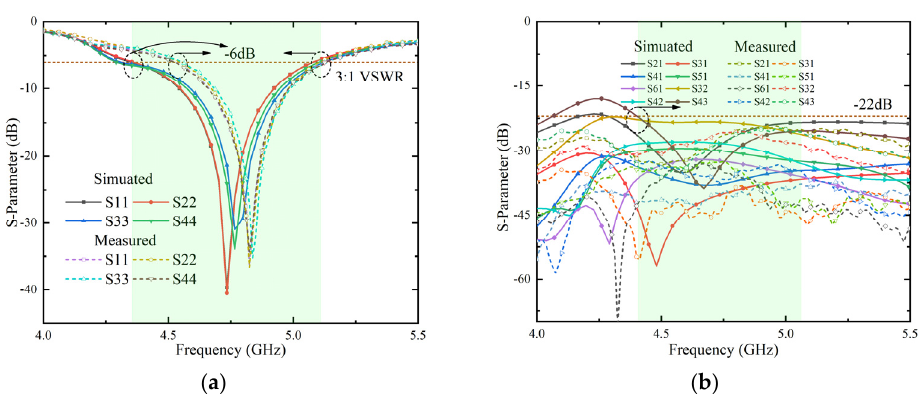
( b ) Figure 12. Photographs of the test site where the MIMO antenna was tested. ( a ): Vector network measurement analyzer and ( b ): SATIMO anechoic chamber. 3.1. S-Parameters and Efficiency Thanks to the symmetrical arrangement of the MIMO antenna system, only the simulation and measurement results of the part of the antenna elements are analyzed and compared here.